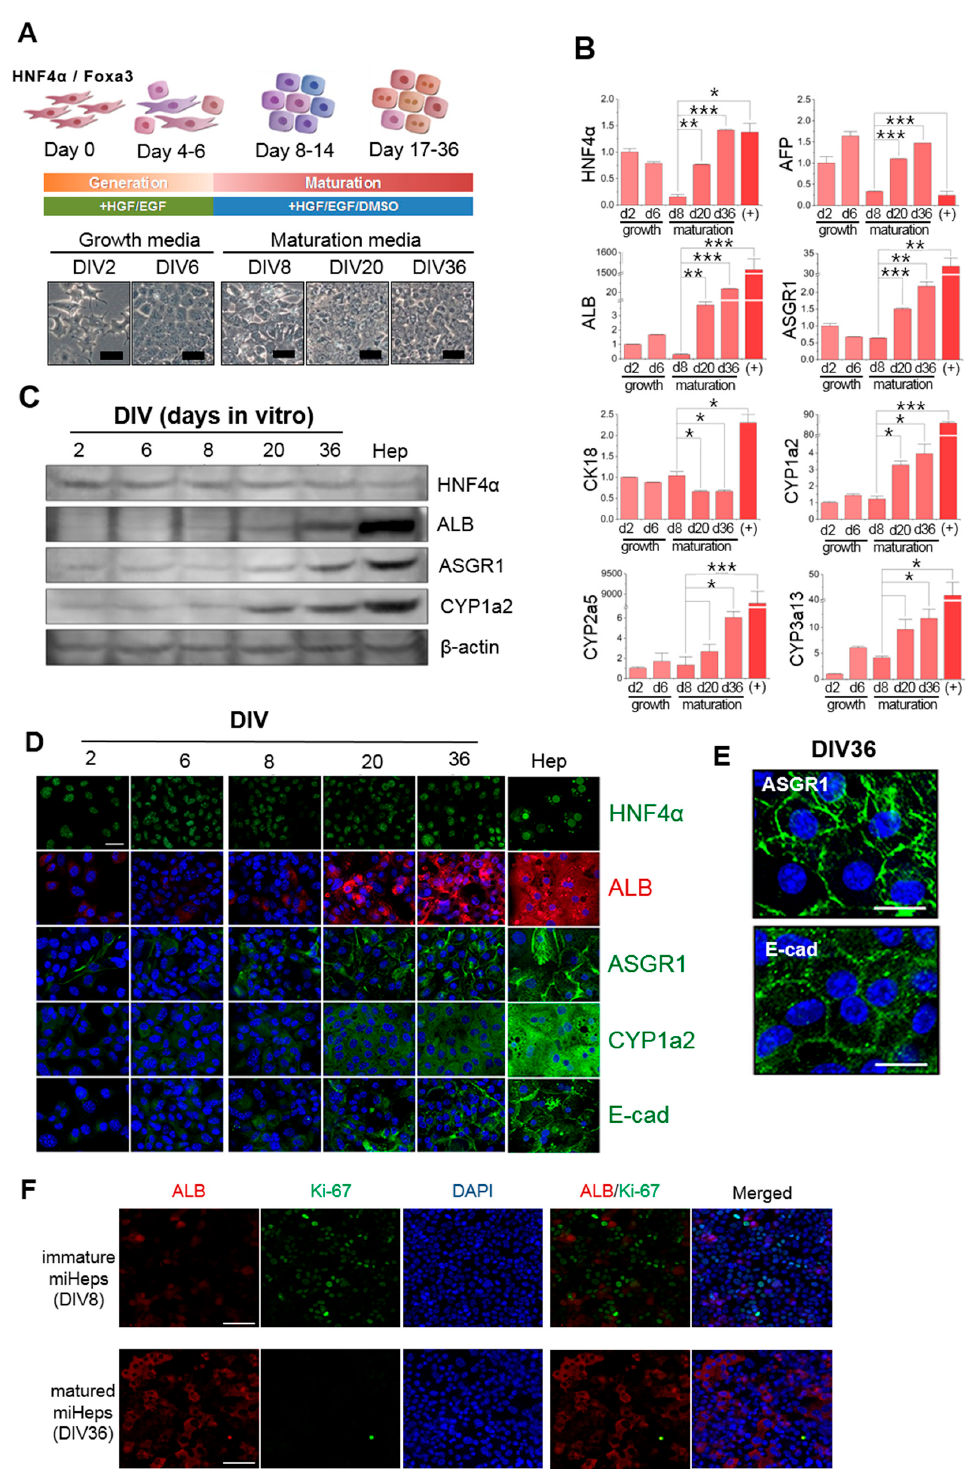
Figure 1. Maturation of mouse induced hepatic progenitors (miHeps). ( A ) Schematic overview of miHep maturation procedure (Scale bar: 50 µ m). Real-time PCR ( B ) of the hepatic genes HNF4 α , AFP, CK18, ALB, ASGR1, and CYP450s. Data represent the mean ± SD, * p < 0.05; ** p < 0.005; *** p < 0.0005. Immunoblotting ( C ) and immunocytochemistry ( D ) of the hepatic proteins HNF4 α , ALB, ASGR1, CYP1a2, and E-cad in miHeps (Scale bar: 20 µ m). Primary cultured mouse hepatocytes were used as a positive control. Magnified images of ( E ) ASGR1- and E-cad-stained 36 days in vitro (DIV36)